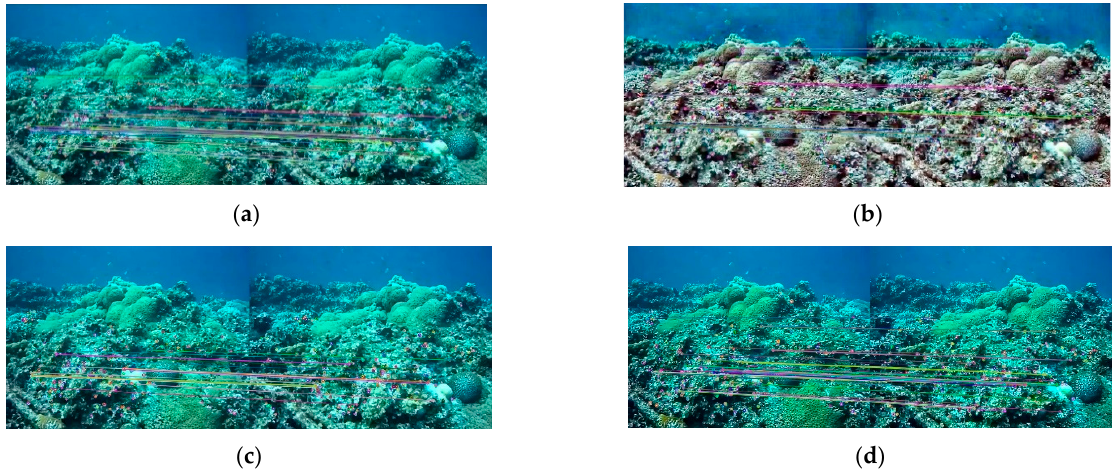
Figure 7. Feature matching results of the Test 1 dataset. ( a ) Original image; ( b ) CLAHE; ( c ) MF; ( d ) DCP.